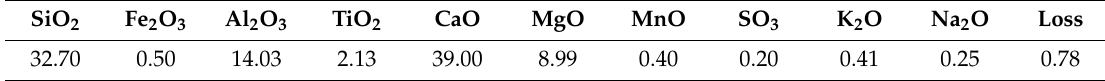
Table 1. Chemical compositions of GGBFS (wt.%).